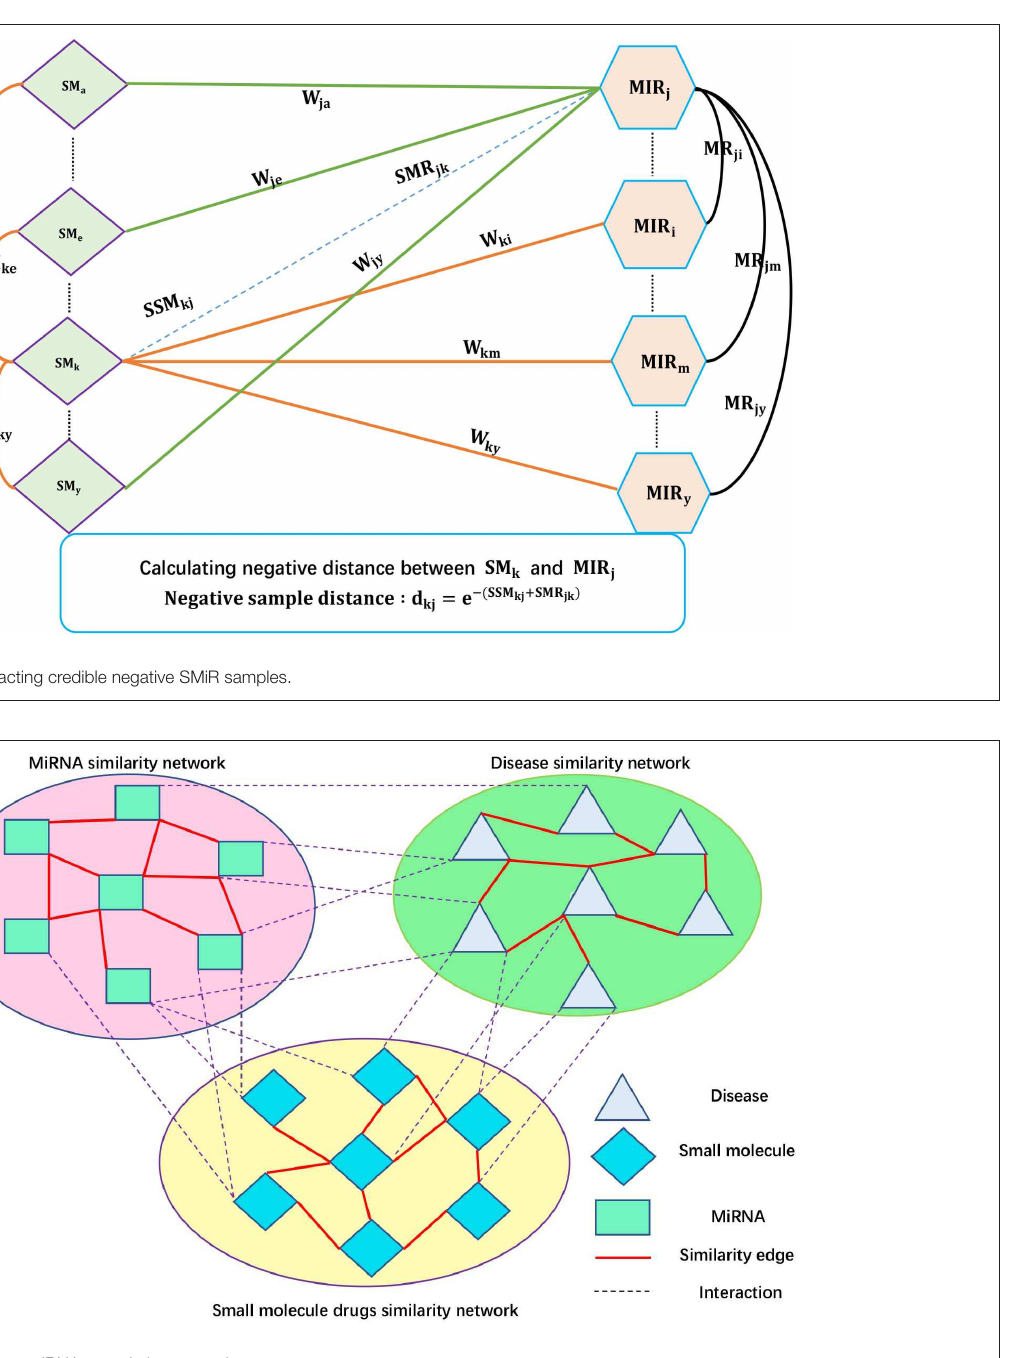
FIGURE 3 | Small molecule-disease-miRNA association